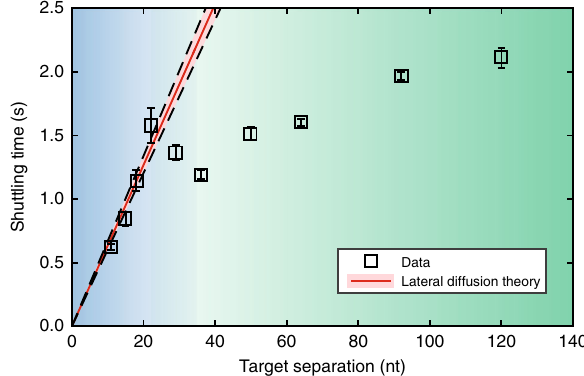
Fig. 3 Cb Ago shuttling behaviour differs across short and large distances. Shuttling time is plotted vs. distance between targets. Squares indicate the mean shuttling time for each DNA construct. The plotted error bars indicate the 95% con fi dence interval of 10 5 bootstrapped dwell times. The red line indicates the lateral diffusion model where the fi rst four datapoints are fi tted with k esc = 15.8 s − 1 . The shaded red region indicates its 95% con fi dence interval derived from bootstrapping the data. The blue region indicates where the shuttling time follows lateral diffusion theory. This theory breaks down for larger distances (green). Source data are provided